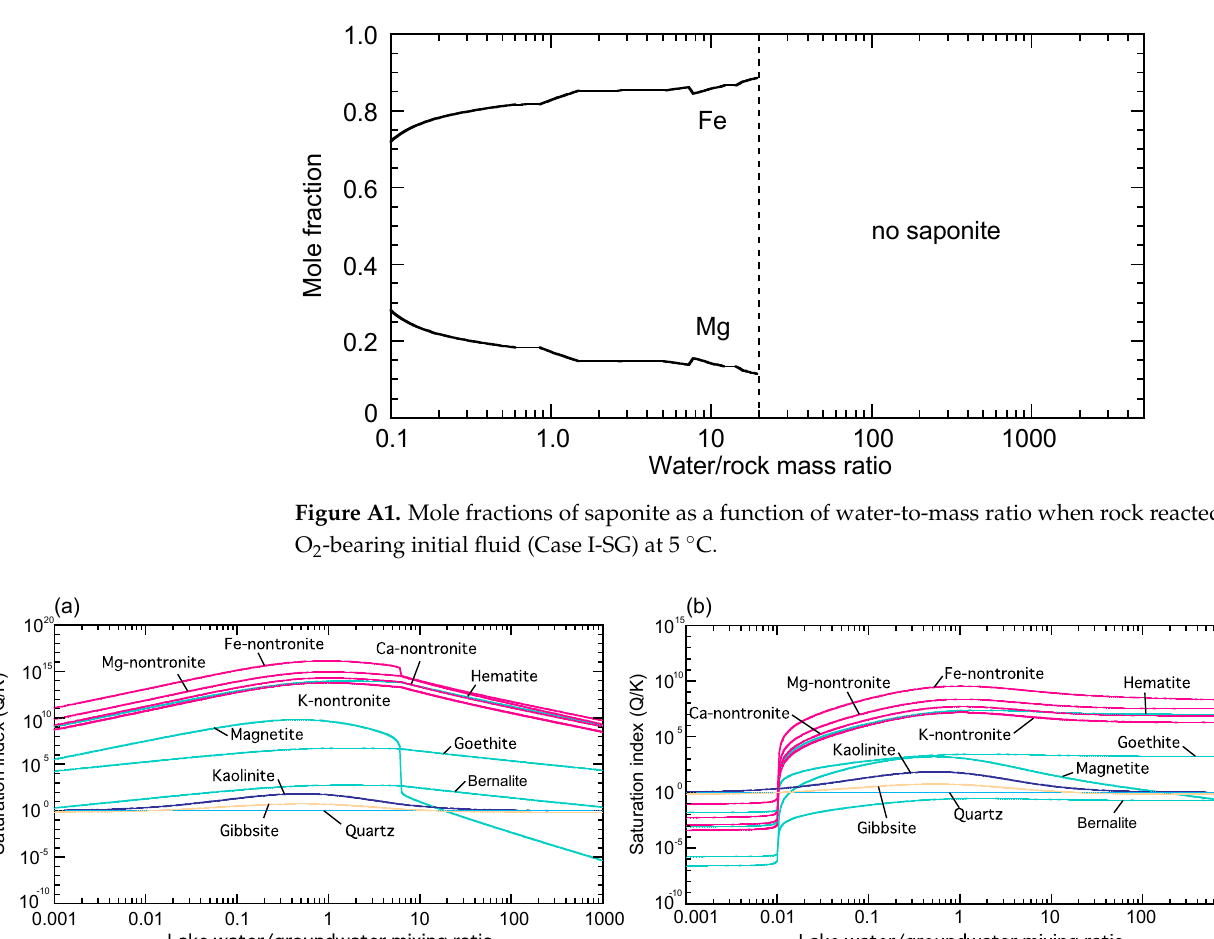
Figure A4. Bioavailable energy (J/kg mixed fluid) from aerobic Fe 2+ -oxidizing magnetite formation at p O 2 of 0.01, 0.2, 2, and 20 mbar. References 1.